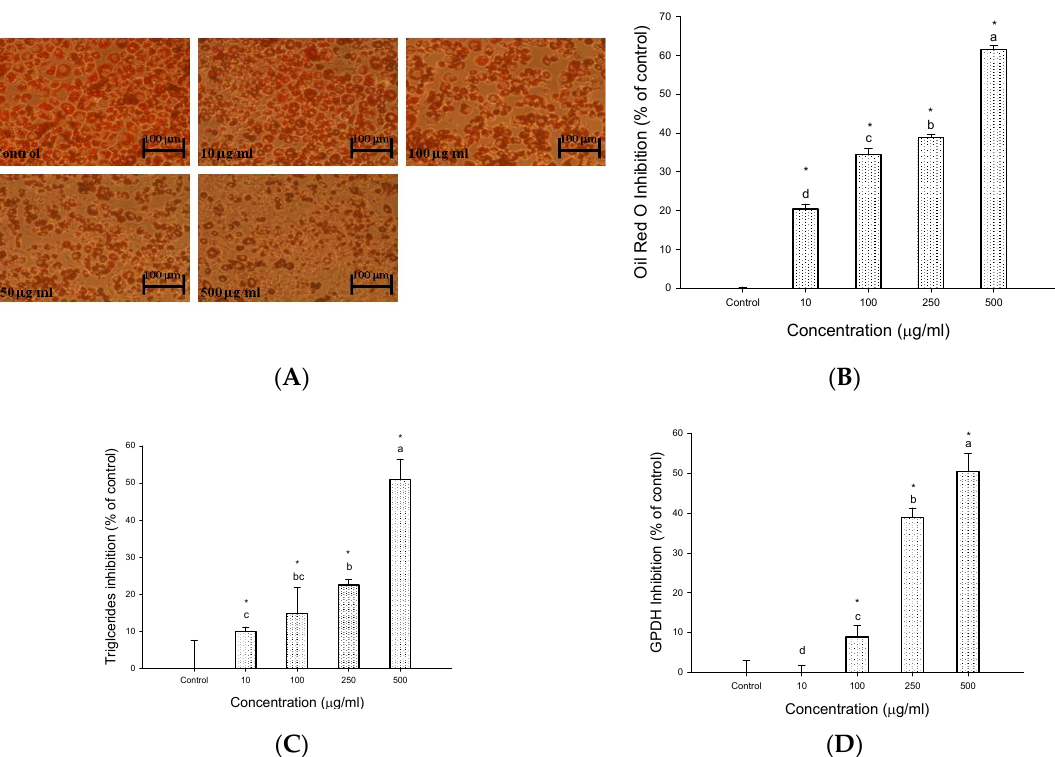
Figure 1. Effect of ethanol extracts of Djulis (EECF) on adipogenesis. ( A ) The microscopic images of Oil red O ‐ staining of EECF ‐ treated 3T3 ‐ L1 cells. ( B ) Oil red O ‐ staining of EECF ‐ treated 3T3 ‐ L1 cells. 3T3 ‐ L1 cells were incubated with 10–500 μ g/mL of EECF for 72 h at 37 °C in 5% CO 2 incubator. ( C ) EECF ‐ mediated suppression of intracellular triglyceride levels of 3T3 ‐ L1 cells. 3T3 ‐ L1 cells were incubated with 10–500 μ g/mL of EECF for 72 h at 37 °C in 5% CO 2 incubator. ( D ) Effect of EECF on GPDH activity in 3T3 ‐ L1 cells. The cells were incubated with 10–500 μ g/mL of EECF for 72 h at 37 °C in 5% CO 2 incubator. Data are expressed as the mean ± SD of three independent experiments. * ( p < 0.05), compared to the control. Values in each concentration with different superscript letters are significantly different ( p < 0.05).